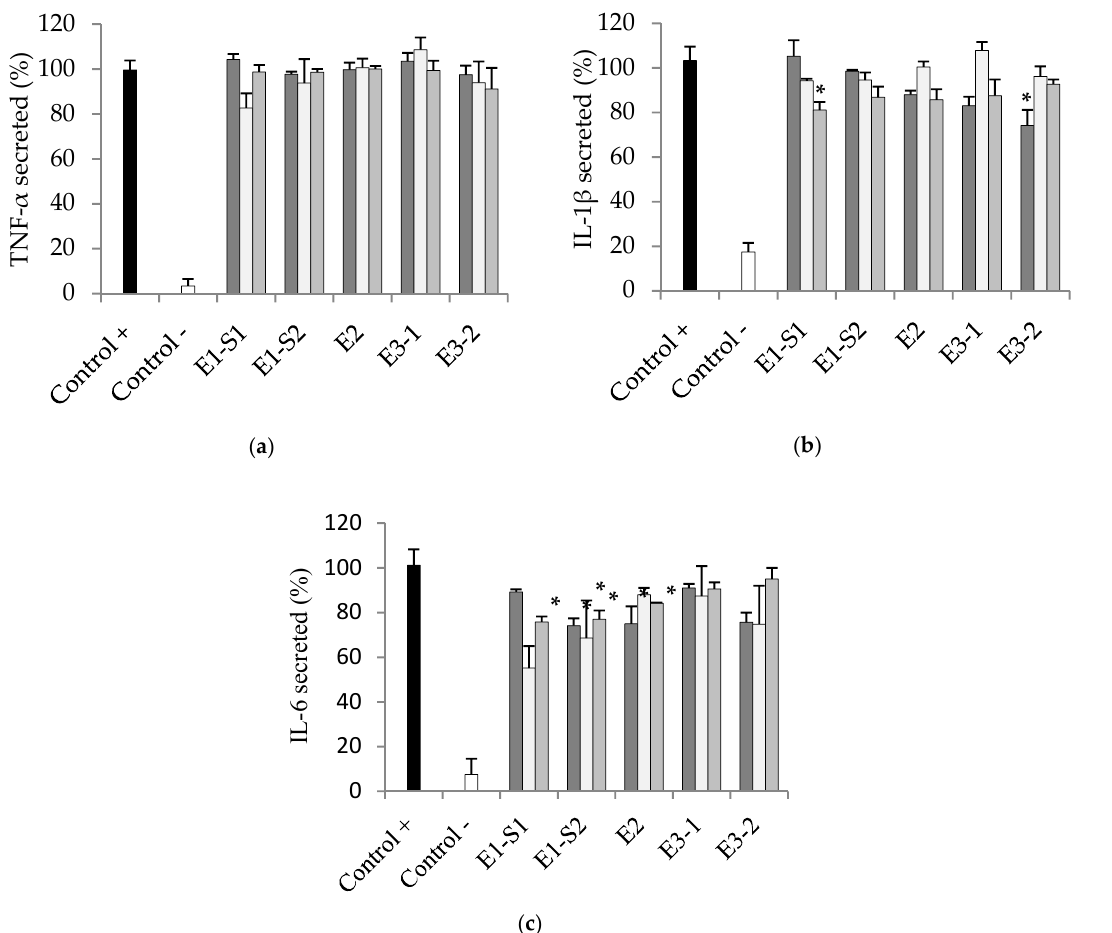
Figure 1. Levels of TNF- α ( a ), IL-1 β ( b ) and IL-6 ( c ) secreted by THP-1/M cells activated with LPS in the presence of supercritical fluid extracts from heather ( ■ ), marigold ( ■ ) and a combined heather + marigold (50:50) extraction ( ■ ). Each bar corresponds to the mean of three determinations ± SD. * Denotes statistical differences between control positive and other samples at p < 0.05.